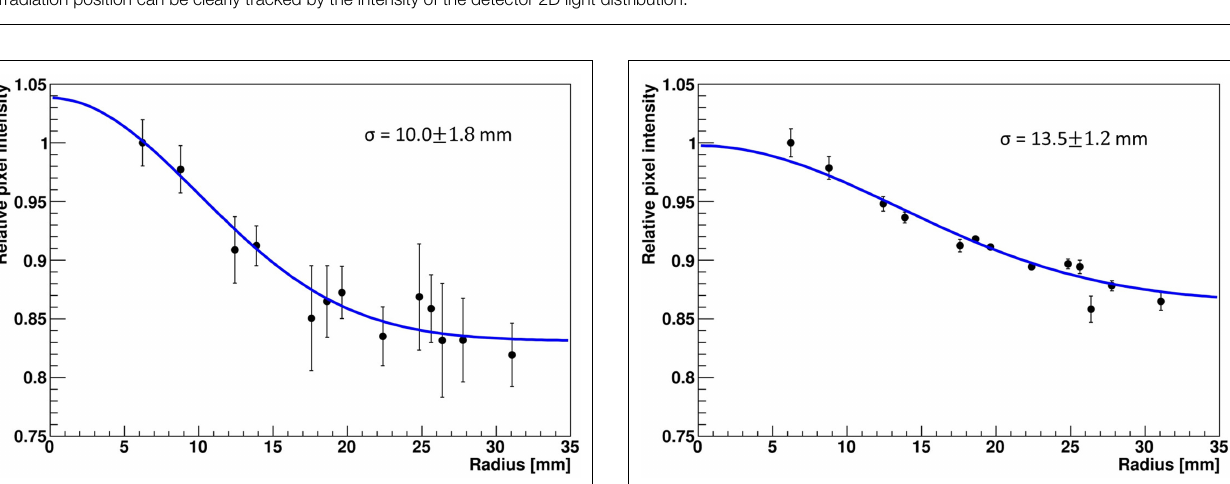
The absorptively wrapped LaBr 3 :Ce detector exhibits a LSF of 23.5 ± 4 mm FWHM ( (cid:27) = 10.0 ± 1.8 mm) derived from the radial projection fit of the 2D light distribution as indicated in Figure 8 .